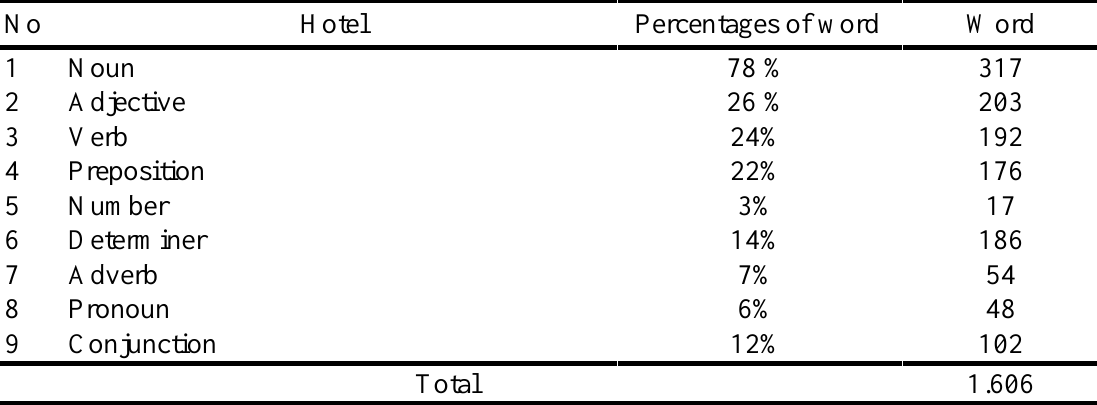
Table 4.1 Part of Speech and Frequency of Words Hotel Home Pages in Bali and